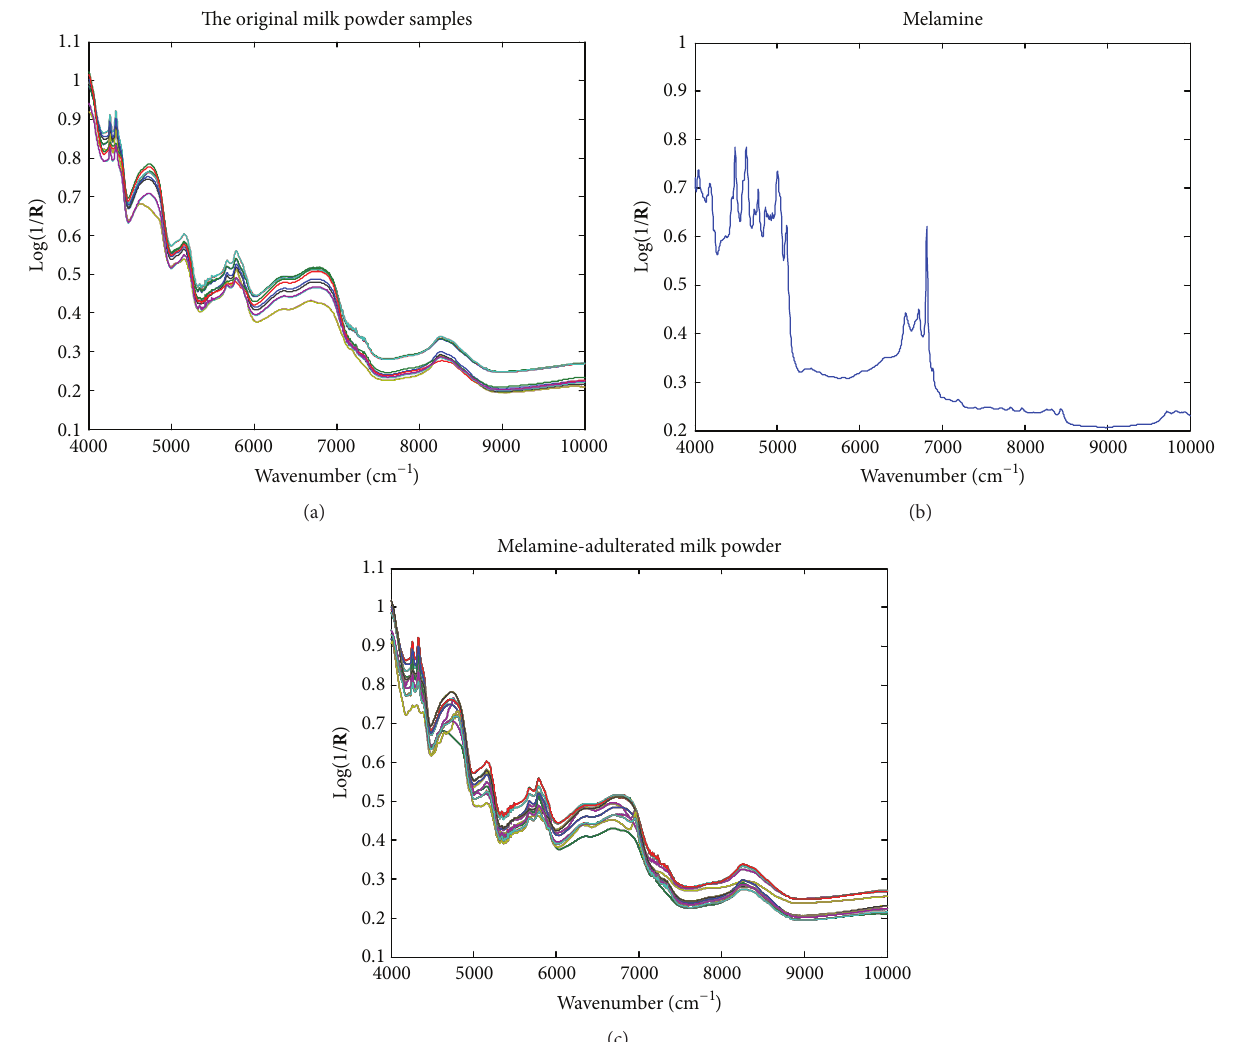
Figure 1: The NIR spectra of the original milk powder samples, pure melamine, and adulterated milk powder